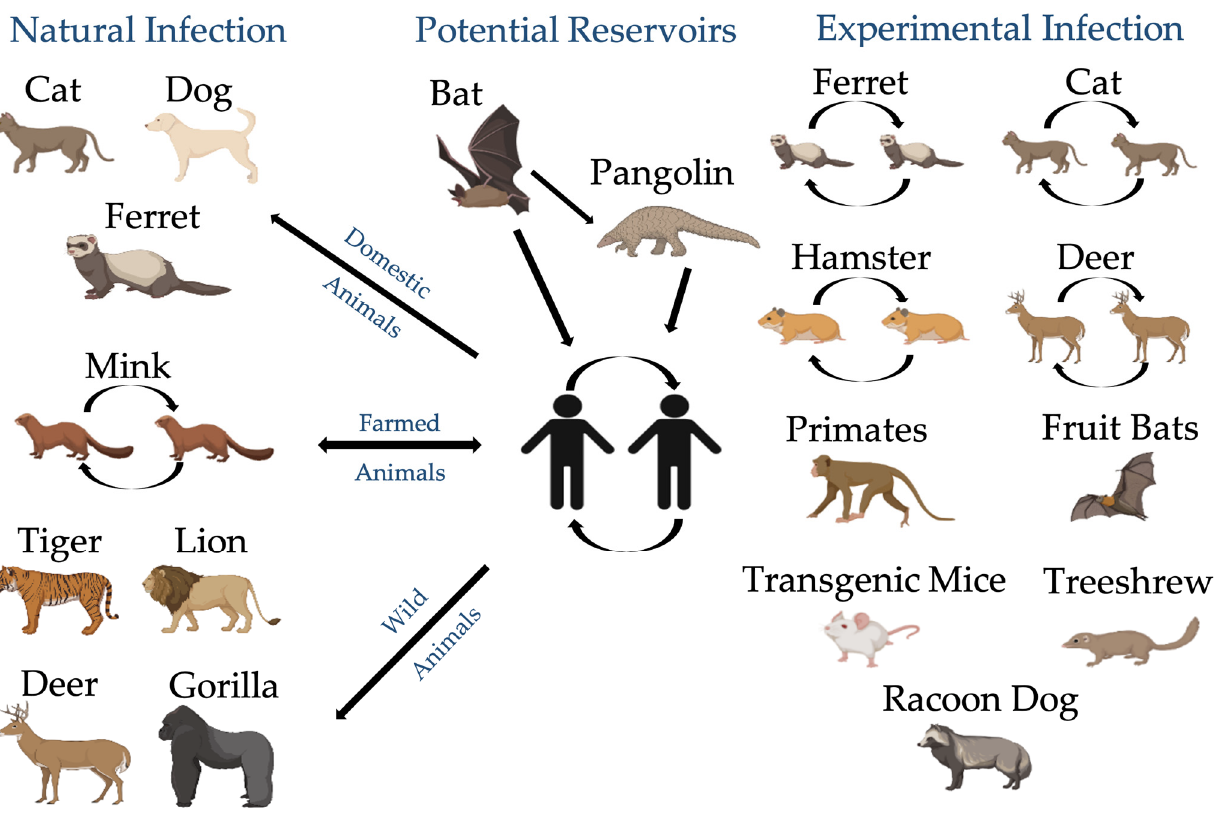
Figure 4. Possible transmission cycle of SARS-CoV-2 in different animal hosts. Created with BioRender.com.